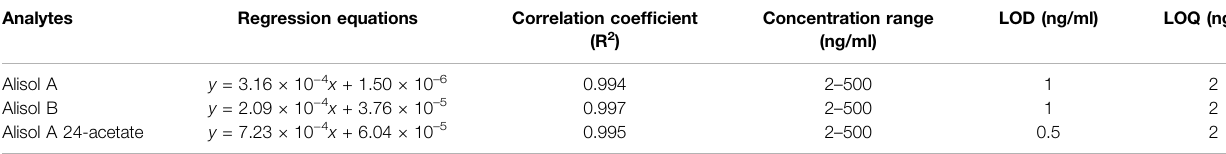
TABLE 4 | Linearity of the three analytes. Analytes